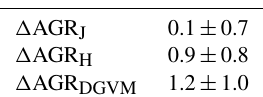
Table 3. Difference between reconstructed and observed AGR ( (cid:49) AGR, in PgCyr − 1 ) during the periods 1940–1950 (positive val- ues indicate an overestimation by the reconstructions). (cid:49) AGR J cor- responds to the reconstruction using E FF , O J , and B J as in Fig. 2 and the other (cid:49) AGR values to the reconstructions based on E FF , O K , the inter-model median value of the land sink estimated by DGVMs (S2), and the different estimations of E LUC , as in Fig. 3.